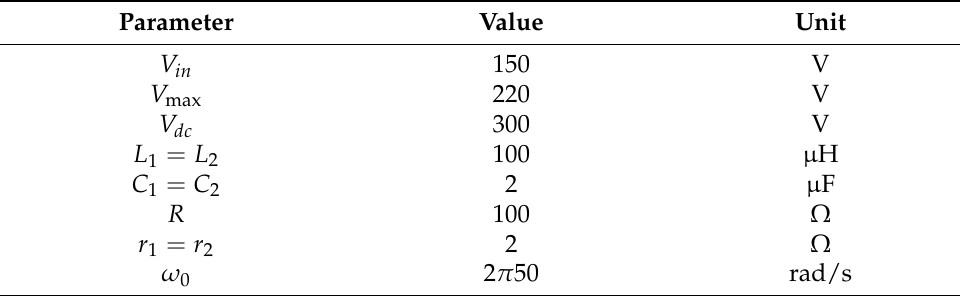
Figure 5. Circuit diagram of the boost inverter. Table 4. Parameters of the boost